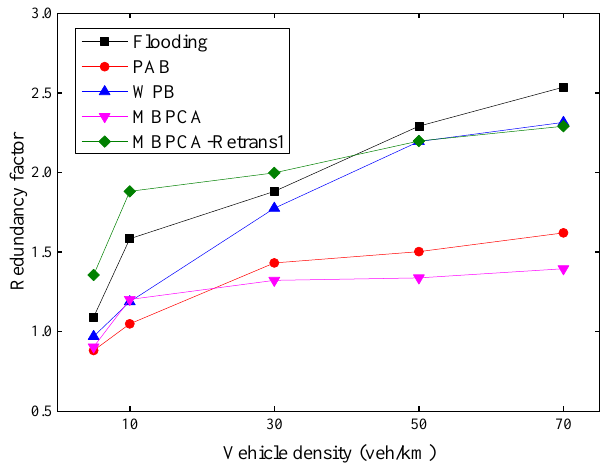
Figure 15. Redundancy factor under different vehicle densities.